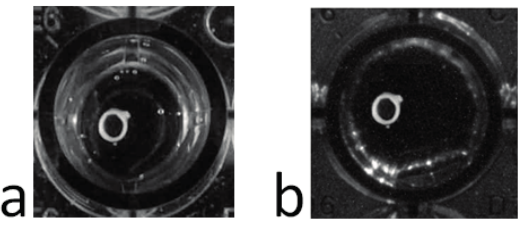
Figure 3. Image of the same aorta ring under conditions of equal light without ( a ) and with ( b ) a telecentric